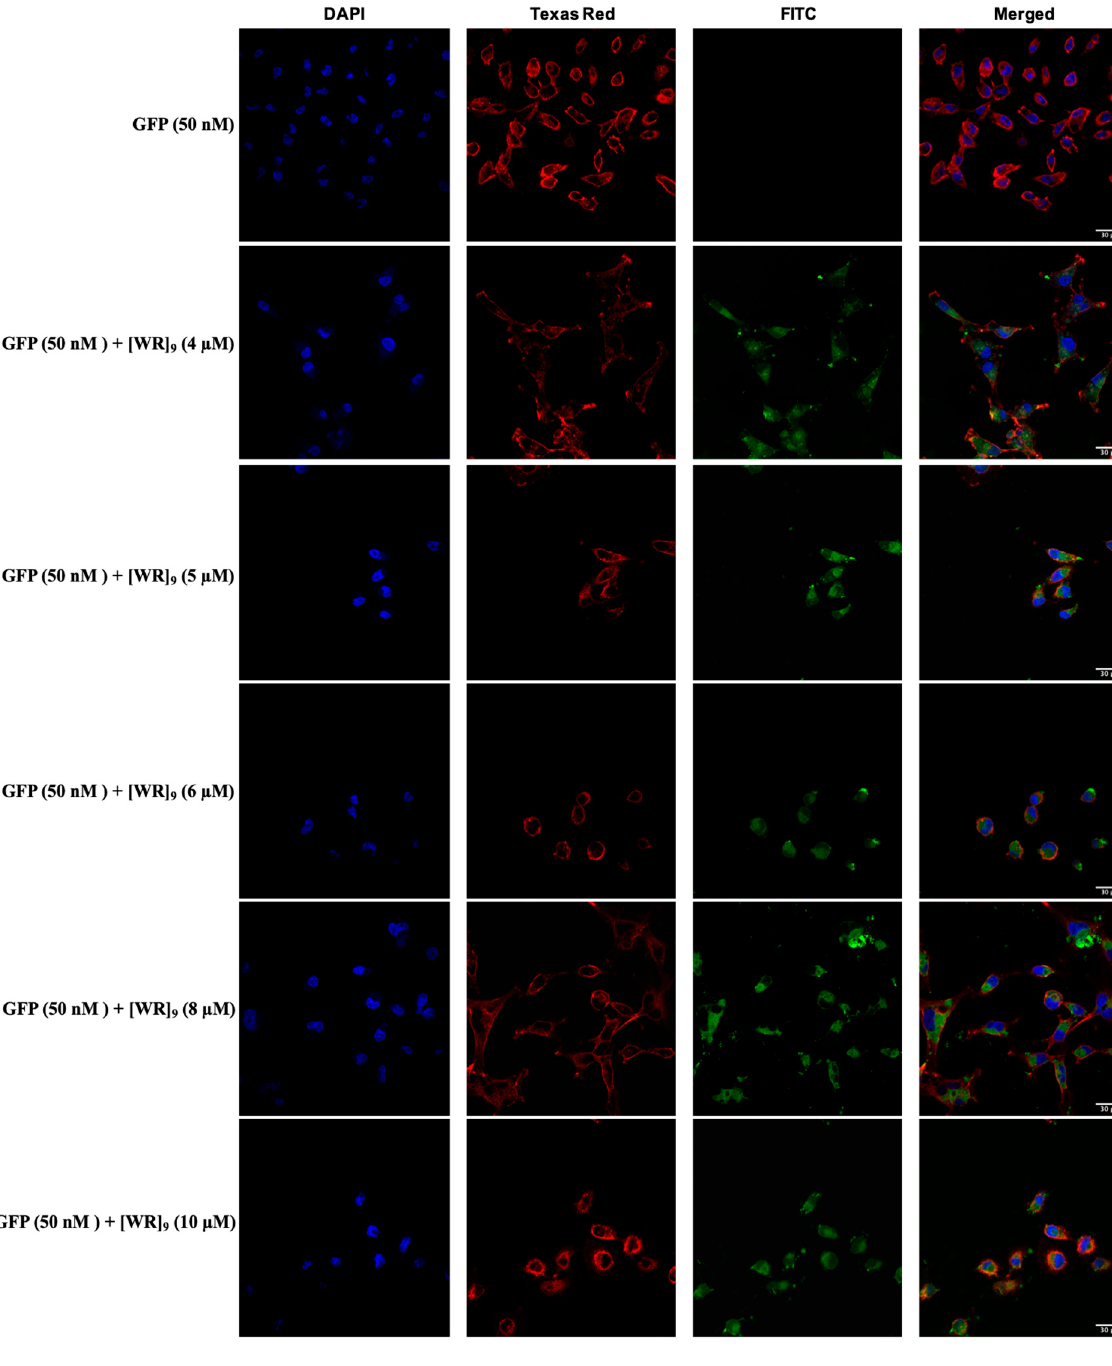
Figure 6. Confocal microscopy images of MDA-MB-231 cells incubated with GFP-[WR] 9 mixture at a peptide concentration range (4–10 µM) and GFP at (50 nM) for 3 h. The blue, red, and green channels visualize DAPI (used to stain the nucleus), Texas Red (used to stain the cell membrane), and GFP, respectively.